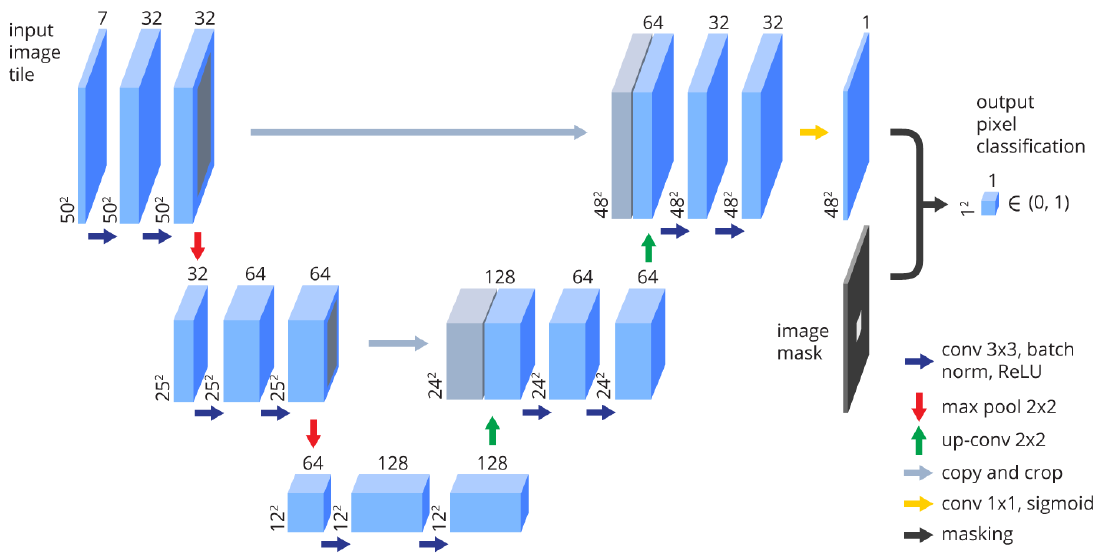
Figure 3. A U-Net (a type of CNN) with two down-convolutional blocks and two up-convolutional blocks is shown here. A block is comprised of two convolutional-batch norm layers followed by a max pool or up-convolutional layer. We used masking at the loss computation step to train a U-Net on single pixel labels. The pre-masking output is the network’s segmentation